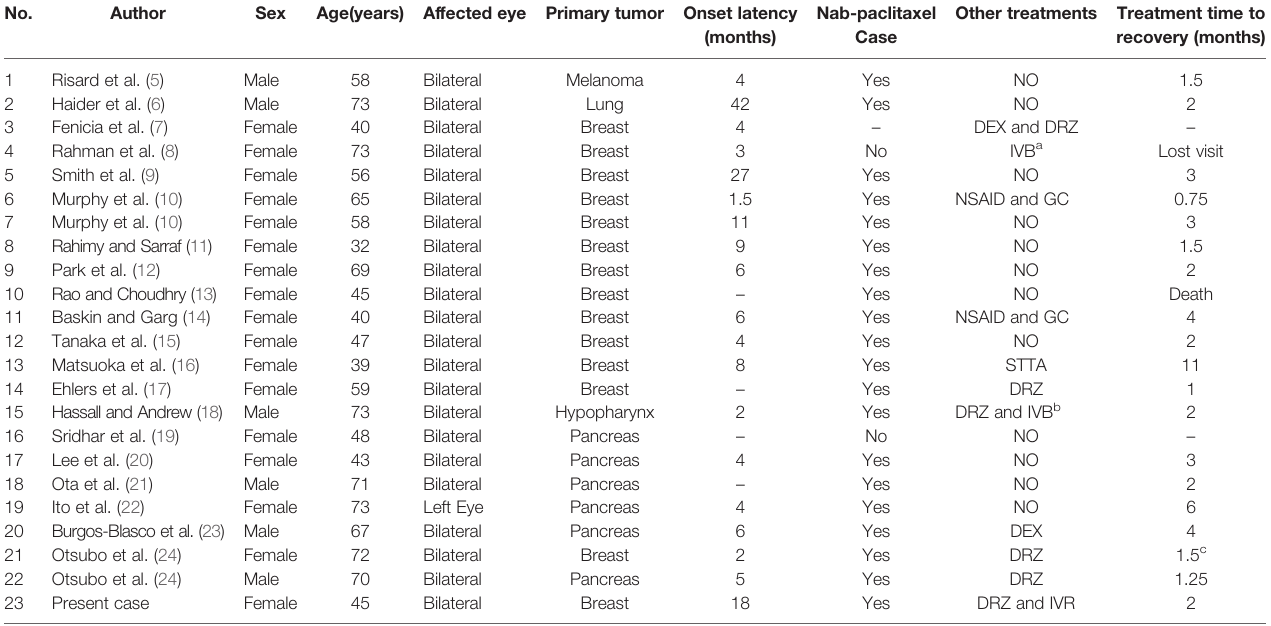
TABLE 1 | Case reports of cystoid macular edema due to albumin-bound